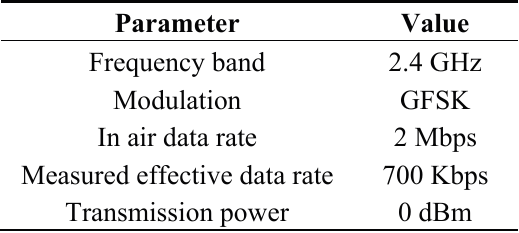
Table 3. Measured characteristics of the low-power